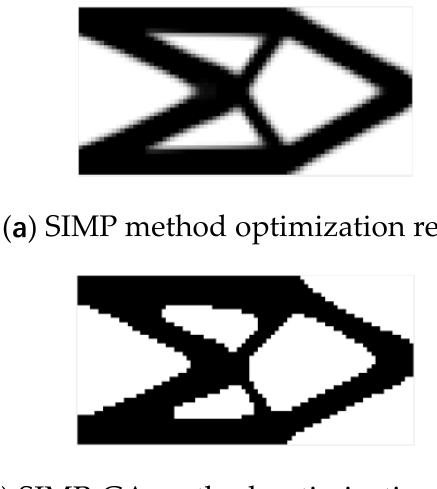
Figure 14. Comparison of results obtained using different optimization methods: ( a ) SIMP method optimization result; ( b ) SIMP-GA method optimization result.